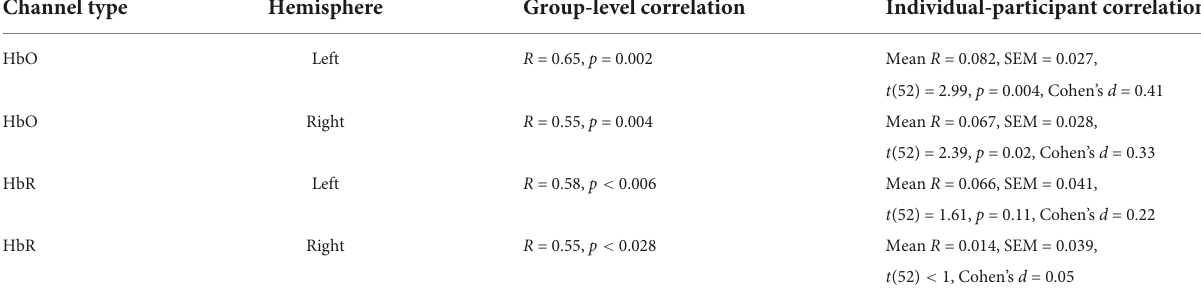
TABLE 3 Correlation between fNIRS signals of two movie repetitions. Channel